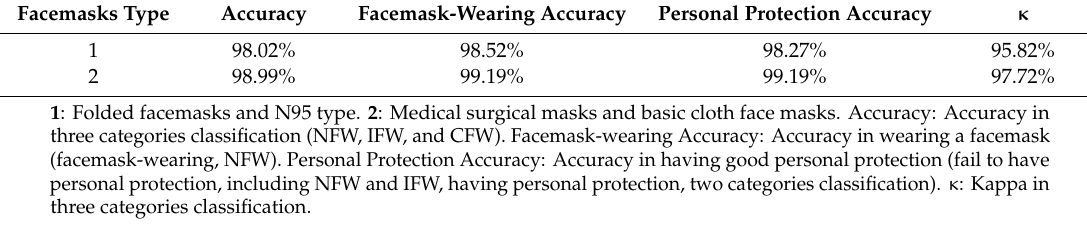
Table 7. Identification result of SRCNet in different types of facemasks.